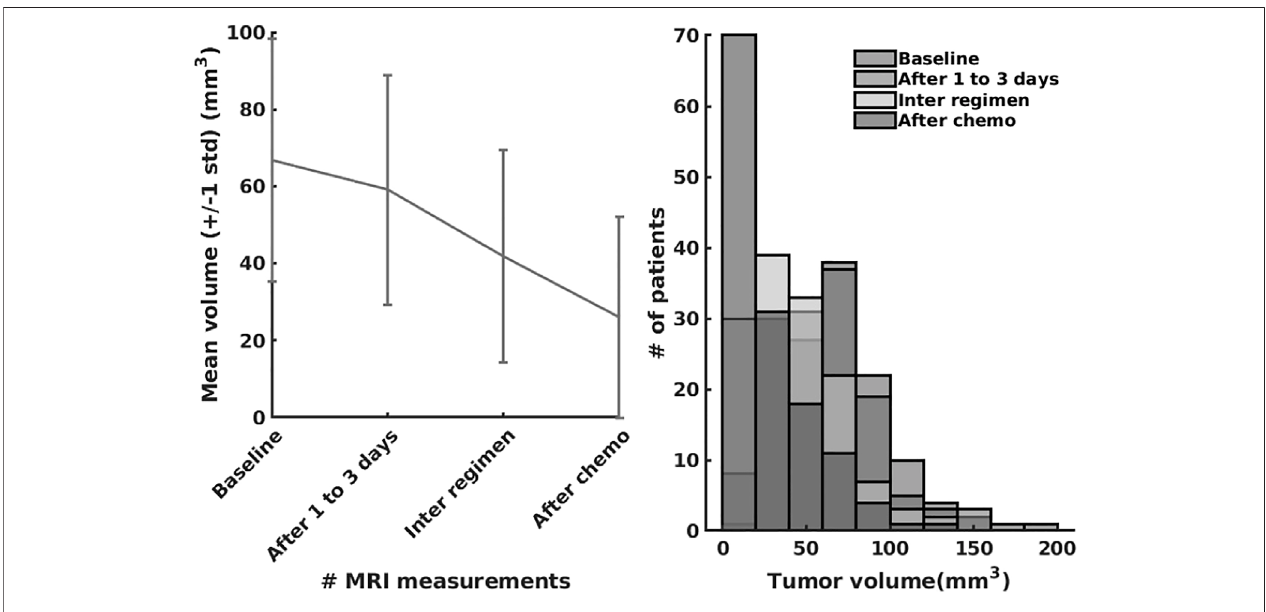
FIGURE 9 | The I-SPY2 trial dataset properties.